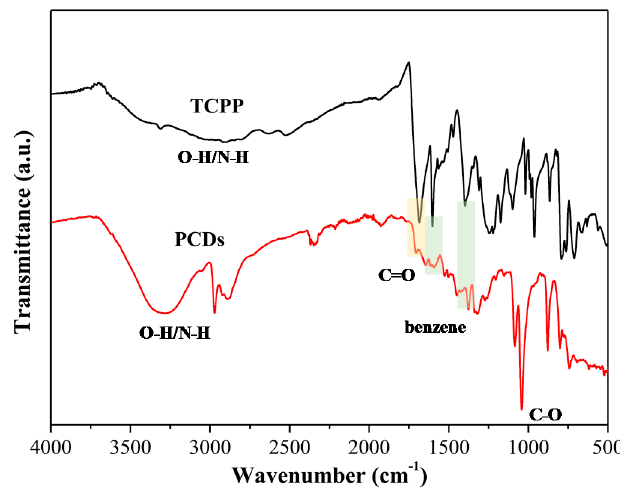
Figure 2. FT-IR spectra of meso-tetra (4-carboxyphenyl) porphin (TCPP) and PCDs.